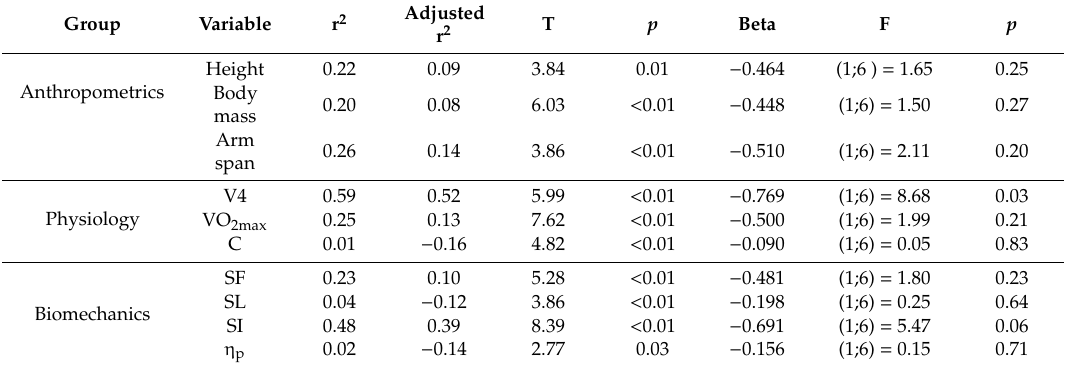
Table 2. Linear regression analysis to assess the potential relationships between T 200m and each group.